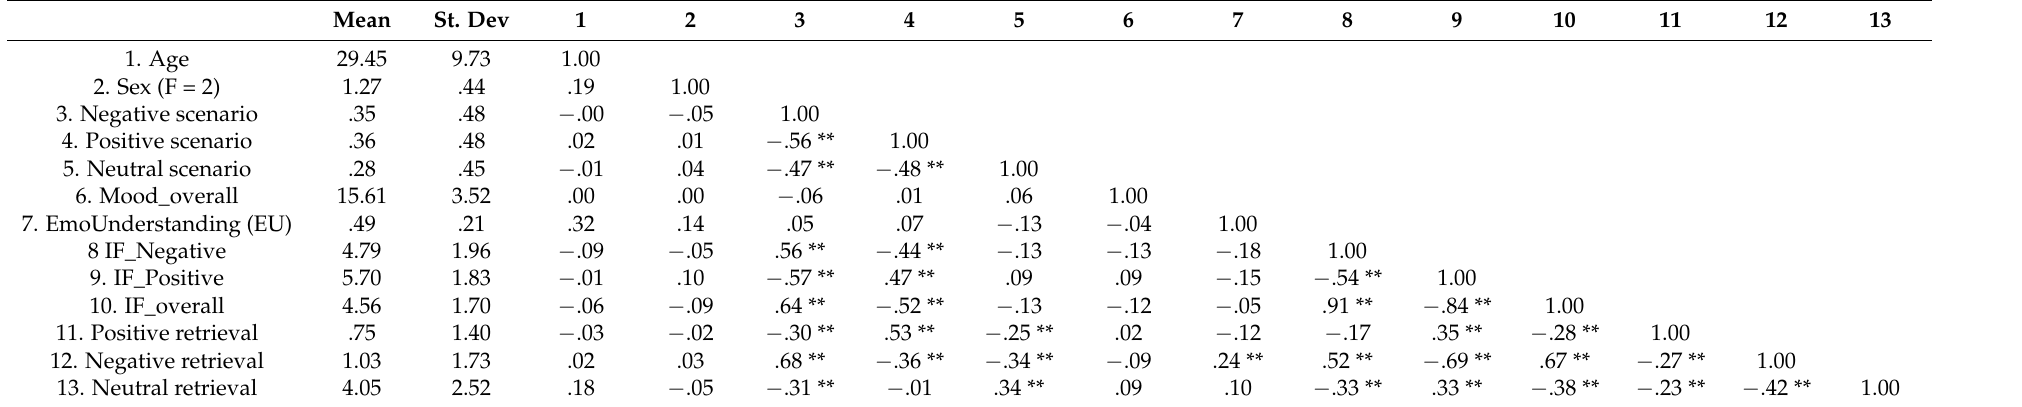
Table 1. Mean, standard deviation, and correlation of the Study